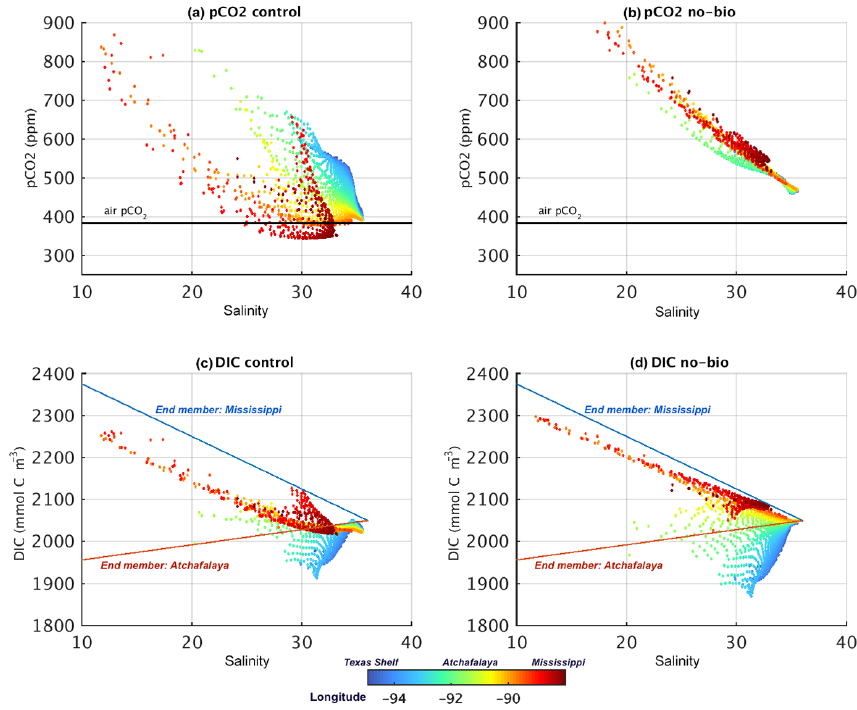
Figure 14. Six-year (2005–2010) spring–summer mean condition of model-simulated sea surface p CO 2 and DIC against salinity for the control run (a, c) and no-biology run (b, d) on the NGoM Shelf; also shown are longitude with colors (note that the Mississippi River delta is located around 89 ◦ W and Atchafalaya River delta is located around 91 ◦ W). Also shown in (c) and (d) are conservative mixing relationships for river end members from Cai et al.